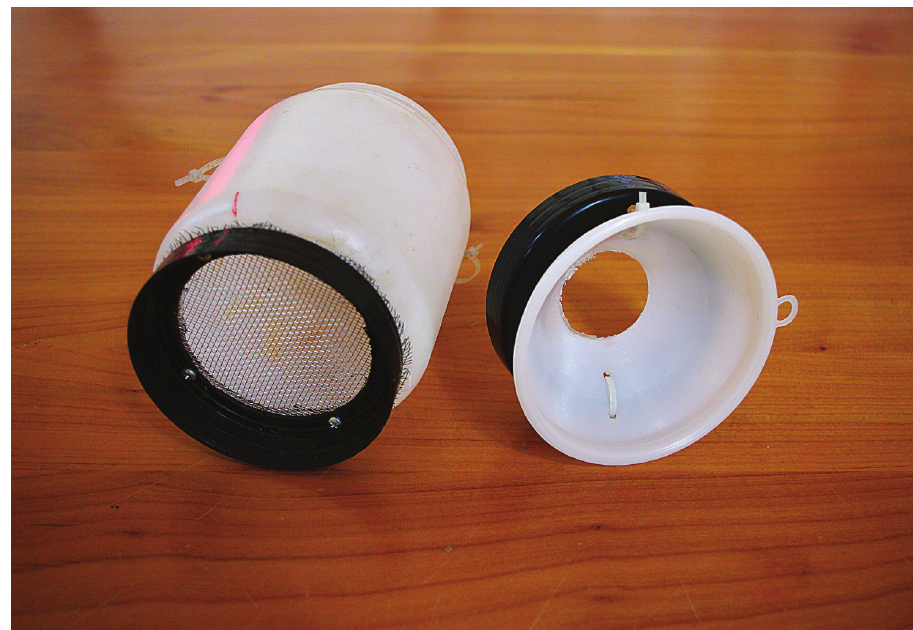
Figure 3. The upper jar of the baited trap modified with a wire insect net and a modified lid in which a plastic funnel has been inserted to collect insects falling into the trap (Photo by M.